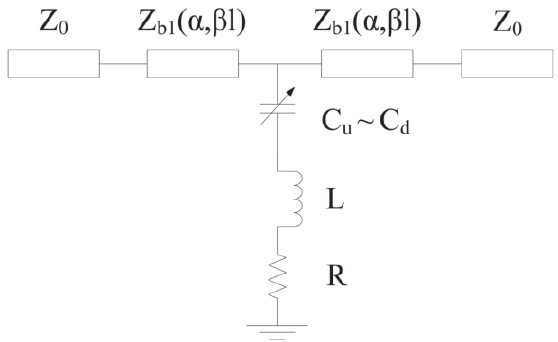
Figure 3. Circuit topology of traditional MEMS switches.